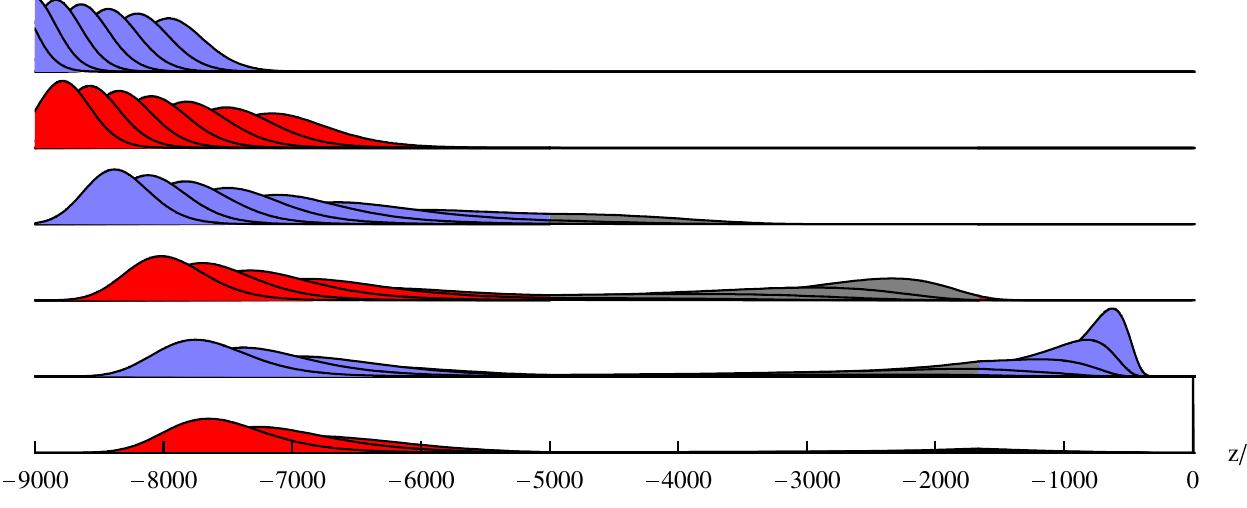
¼ (cid:7) ¼ 1 = 10 m . The 1 2